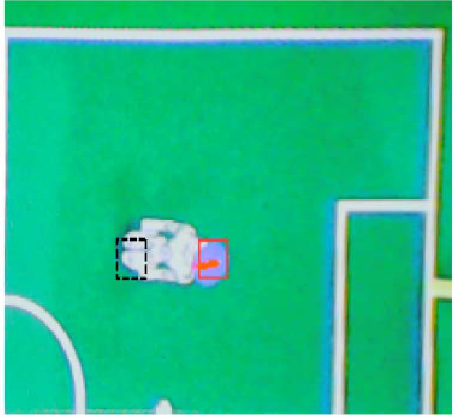
Figure 20. Recognized (red square) and corrected (black square) position of a robot in the